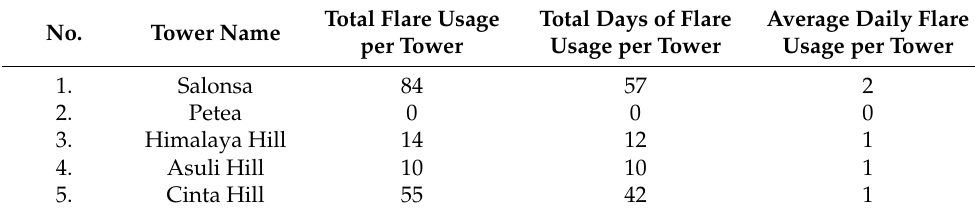
Table 2. A detailed breakdown of total flare, total days of flare, and average daily flare usage for each tower, for 120 days of operations in Larona,